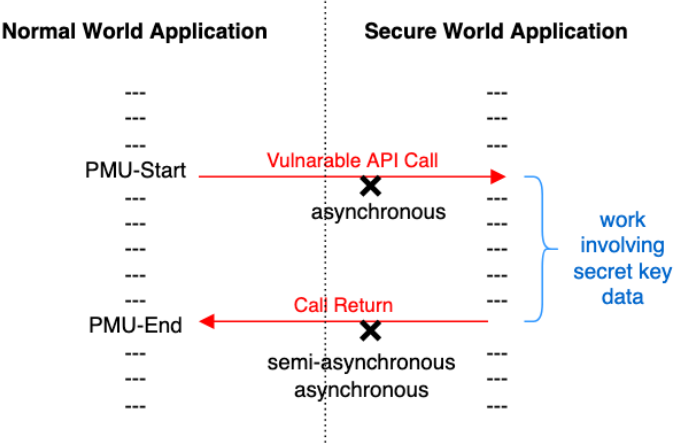
Figure 1. Three attacks: synchronous access attack, semi-asynchronous access attack, and asyn- chronous access